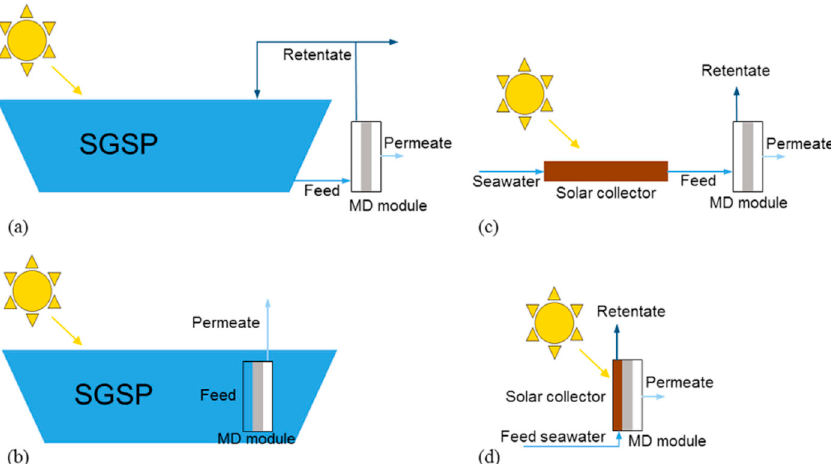
Figure 4. Four configurations coupling MD and solar energy: ( a ) feed water supplied by a SGSP; ( b ) module submerged directly in a SGSP; ( c ) feed water fed by solar collectors; ( d ) feed water heated directly on the membrane surface [151,162].